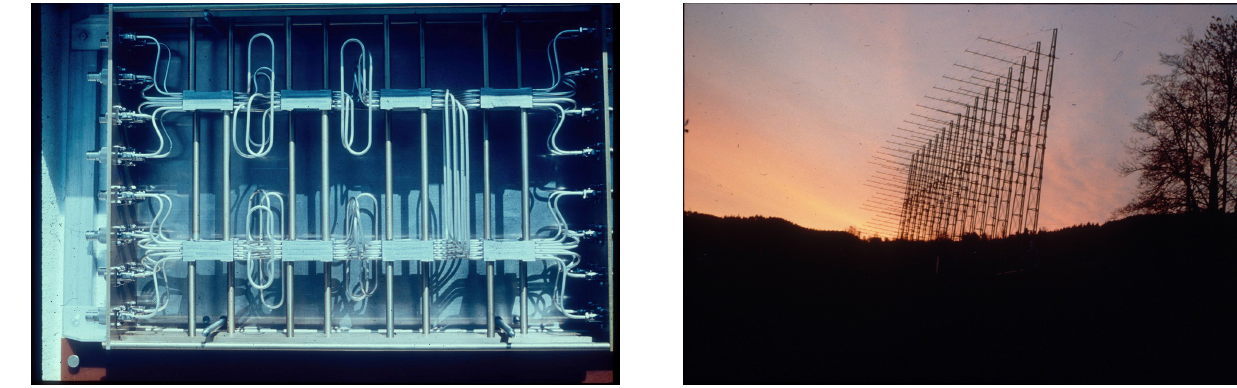
Figure 3. The Butler matrix is a passive phasing network used with the receiving array to form the multi-narrow-lobe pattern.